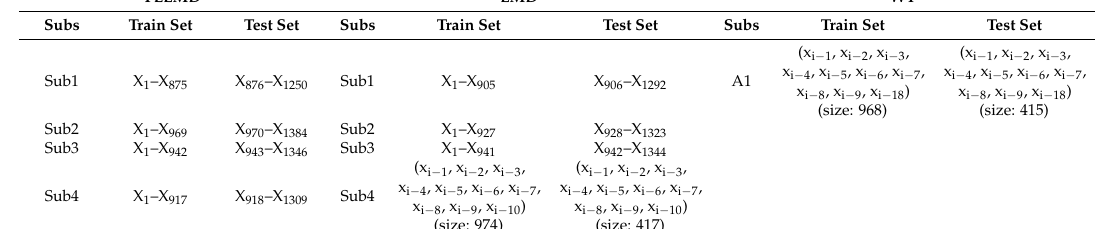
Table A12. The parameters used to determine the input and output of each subsequence prediction.